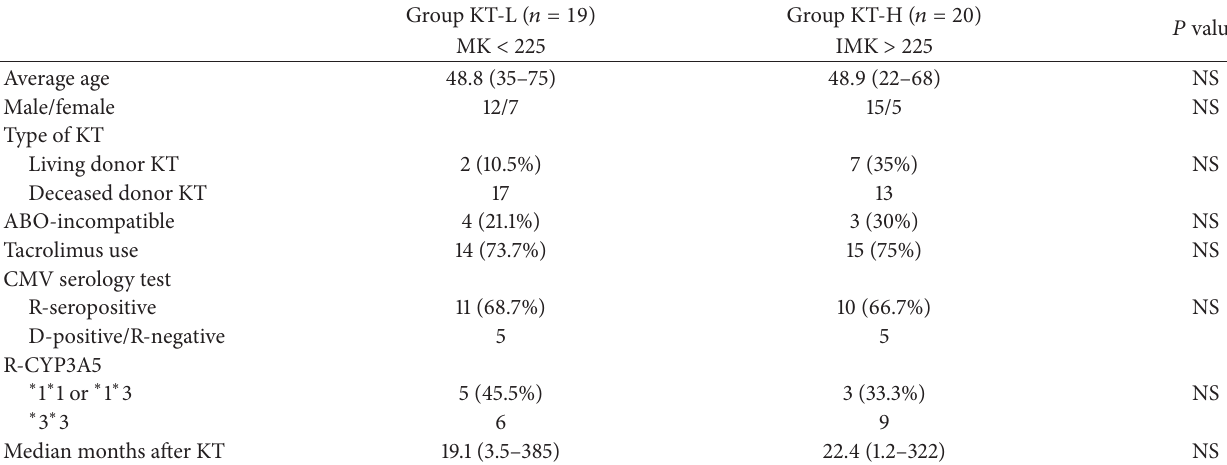
Table 2: Backgrounds of KT